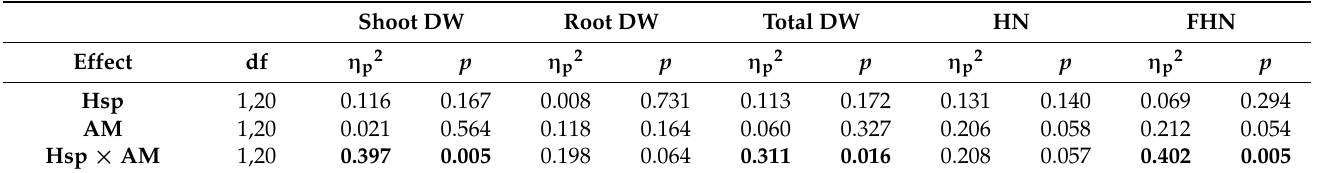
Table 2. Two-way ANOVA results ( η p2 values and p values) for the effects of host species (Hsp) and AM colonization (AM) on shoot DW and root DW, total DW, number of haustoria (HN), and functional haustoria (FHN) of Pedicularis kansuensis . Shoot DW Root DW Total DW